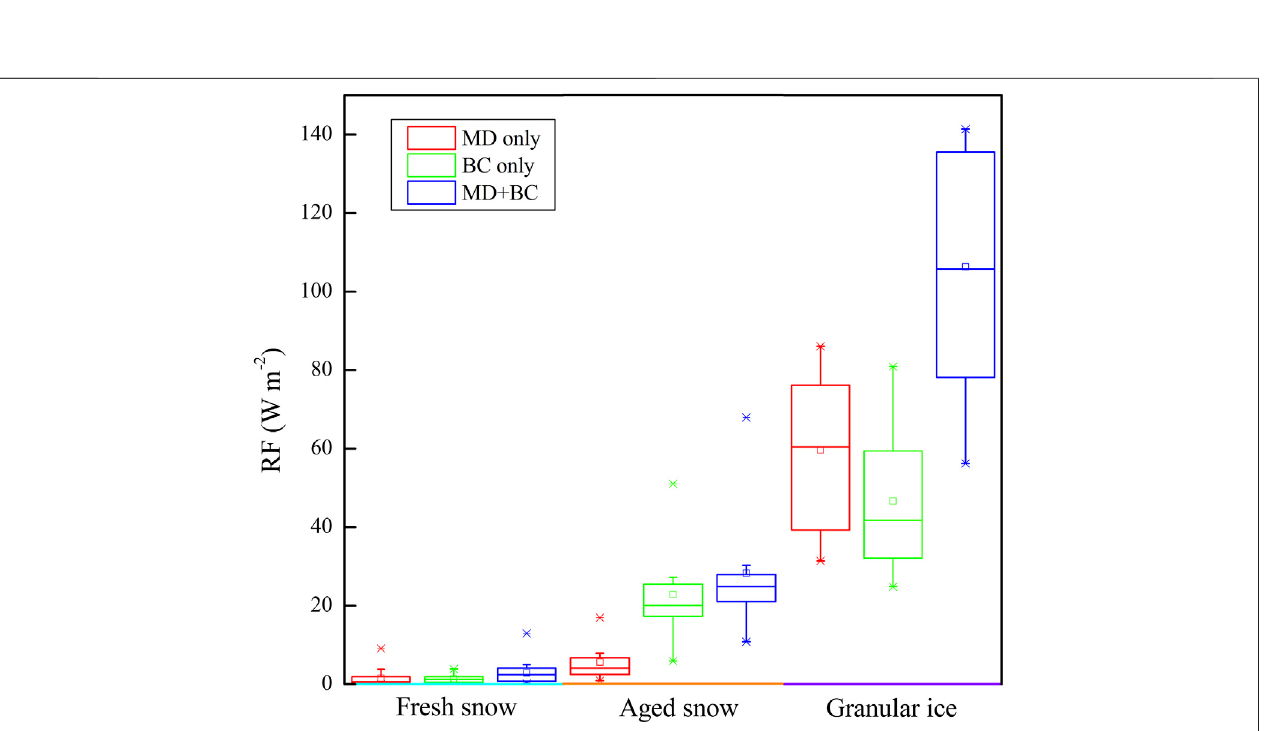
Frontiers in Earth Science |